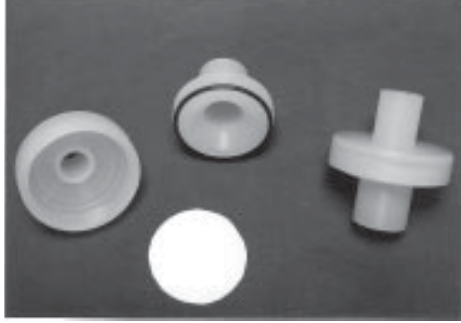
Figure 1. A photograph of the mouthpiece containing the HEPA filter assembled and sepa- rated into three parts showing the screw portion where the two connect. The HEPA pad is lo- cated inside the